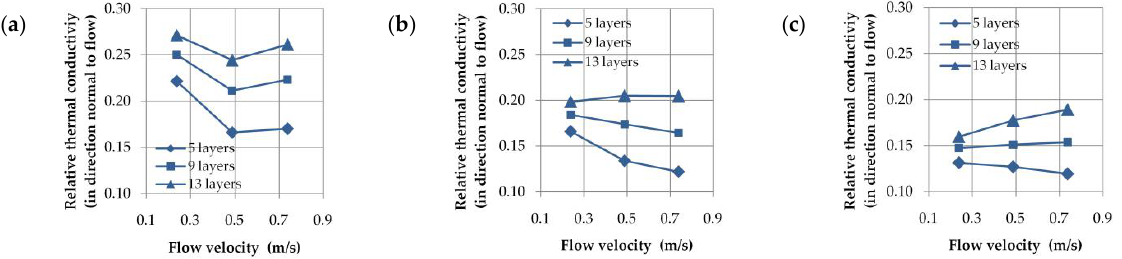
Figure 13. Relative transverse thermal conductivity of porous medium as a function of air flow velocity for a bed containing balls with a diameter of ( a ) 2 mm, ( b ) 3 mm, ( c ) 4 mm.